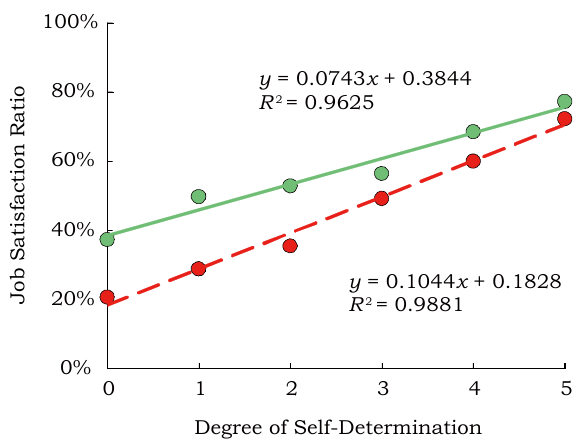
Figure 1. Graph of the job satisfaction ratio versus the degree of